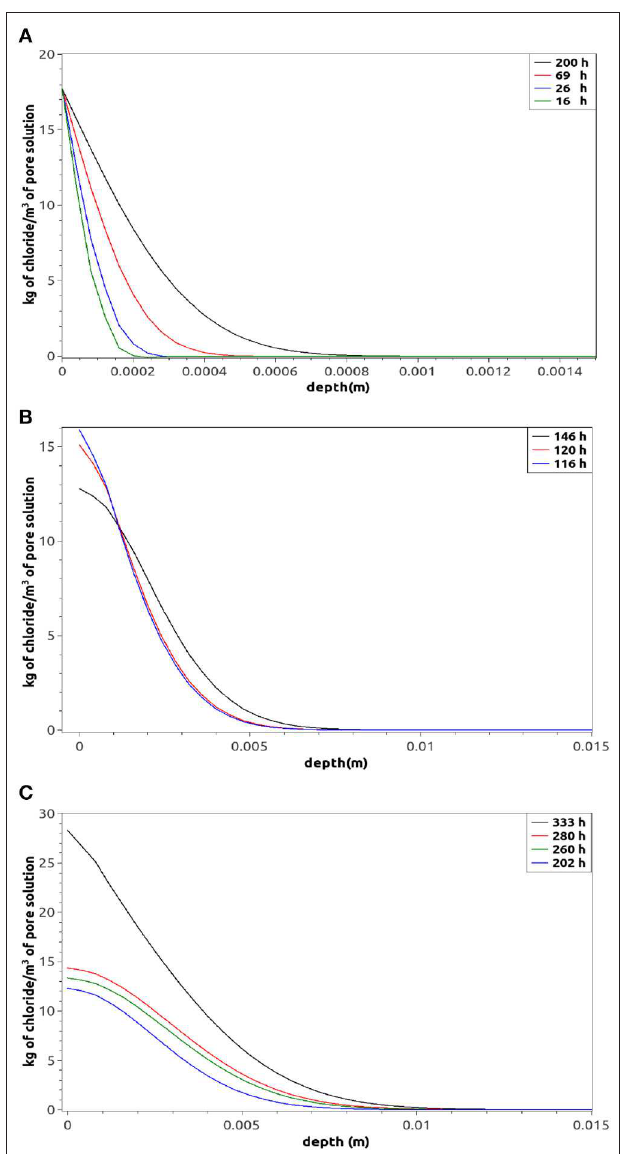
FIGURE 7 | Numerical free chloride profiles for the case (a) in Figure 1 when (A) the bottom boundary is immersed in water, (B) the condition 11 is imposed at 115 min on the bottom boundary, and (C) the condition 11 is imposed at 115 min on the bottom boundary (longer periods after the change of condition).